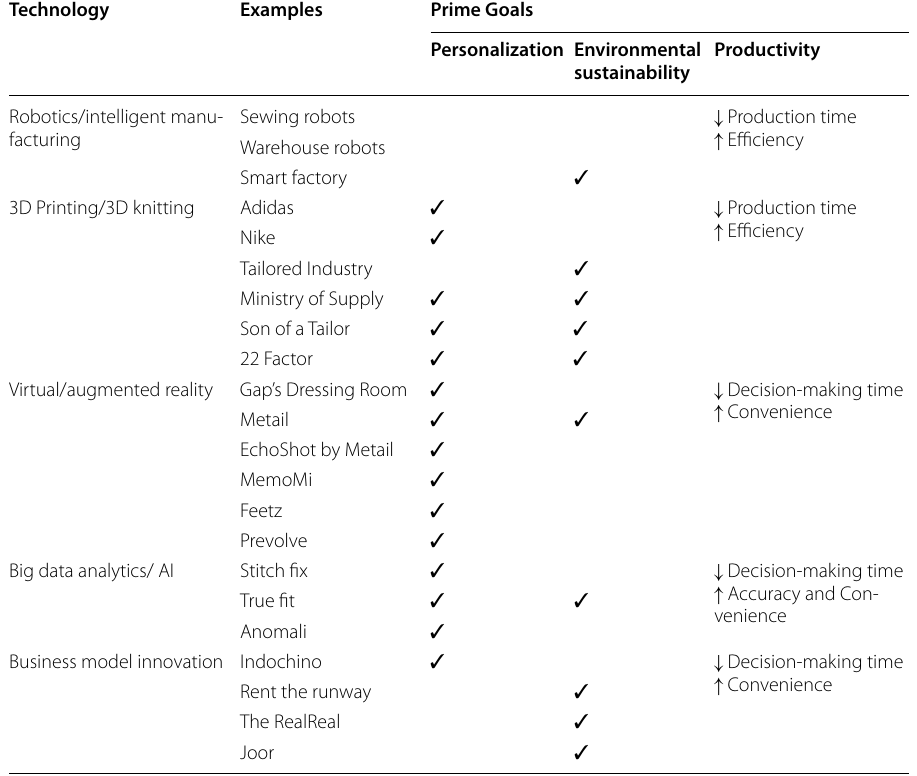
Table 1 Three prime goals addressed by the examples